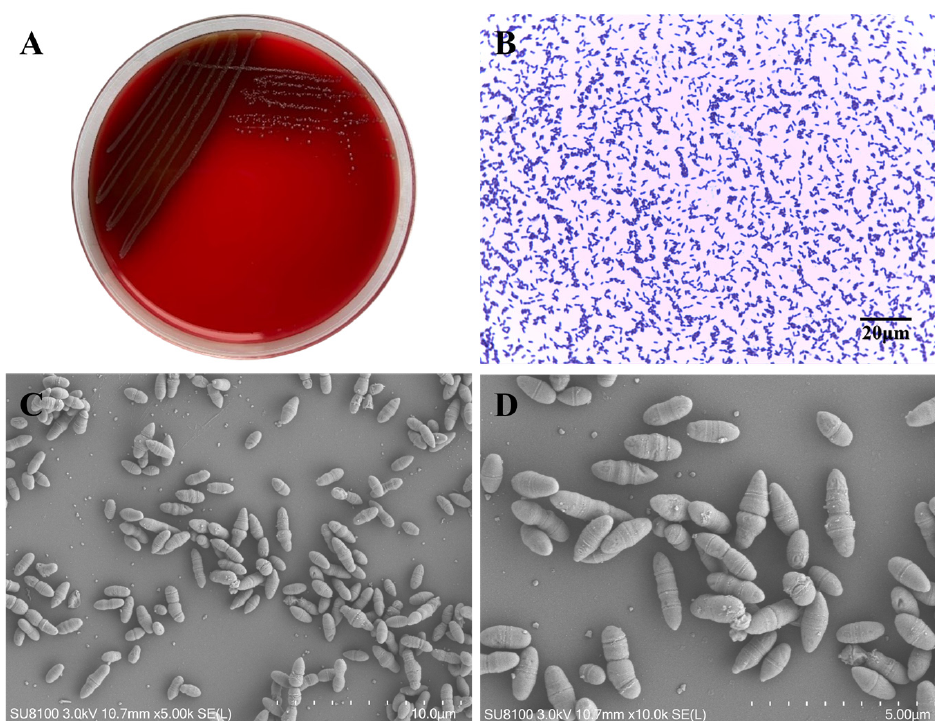
Figure 2. Morphological characteristics of L. garvieae . ( A ) Pinpoint colonies with α -hemolysis were observed on trypticase soy agar with 5% sheep blood; ( B ) Gram-positive cocci were observed under an optical microscope; and ( C , D ) SEM of L. garvieae.